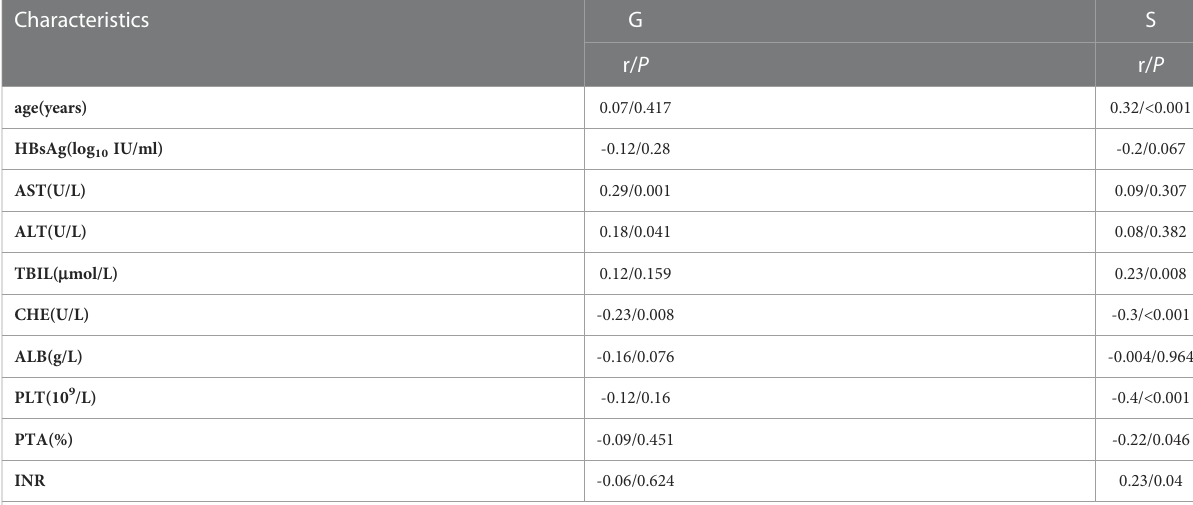
TABLE 3 Histopathological grade distribution of the liver biopsy of HBeAg-negative and HBV DNA-negative patients. Characteristics